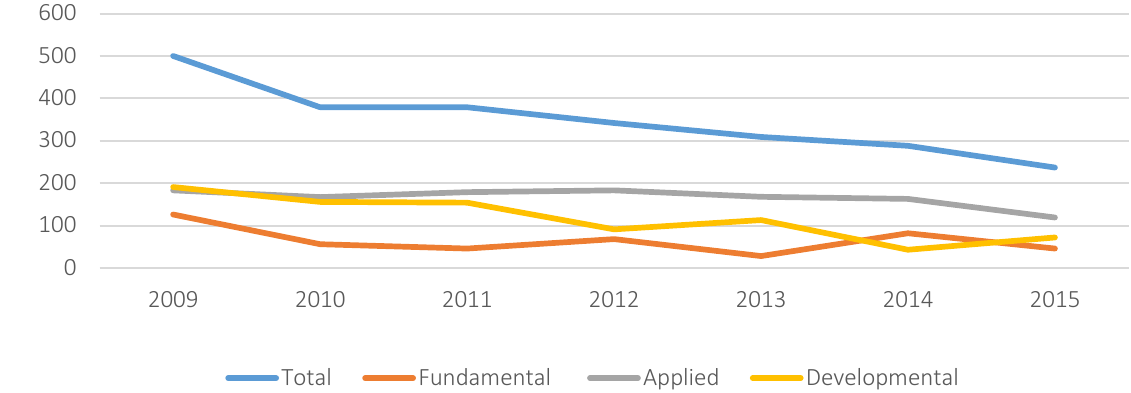
Figure 9. Number of research and development works published in Republika Srpska during the period 2009–2015